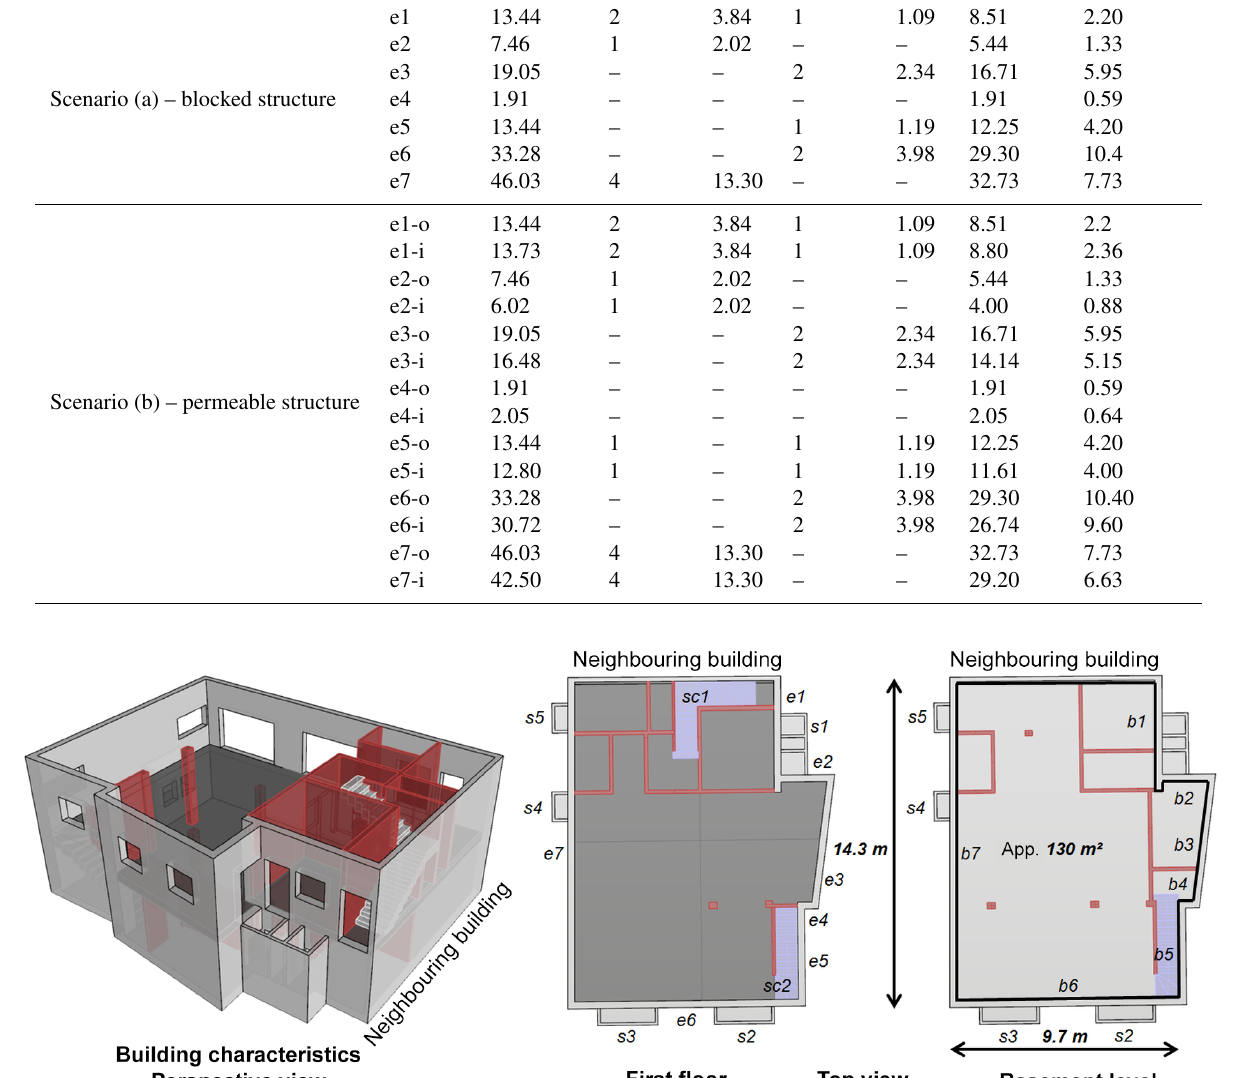
the building with the measures tested in scenario (c) is not